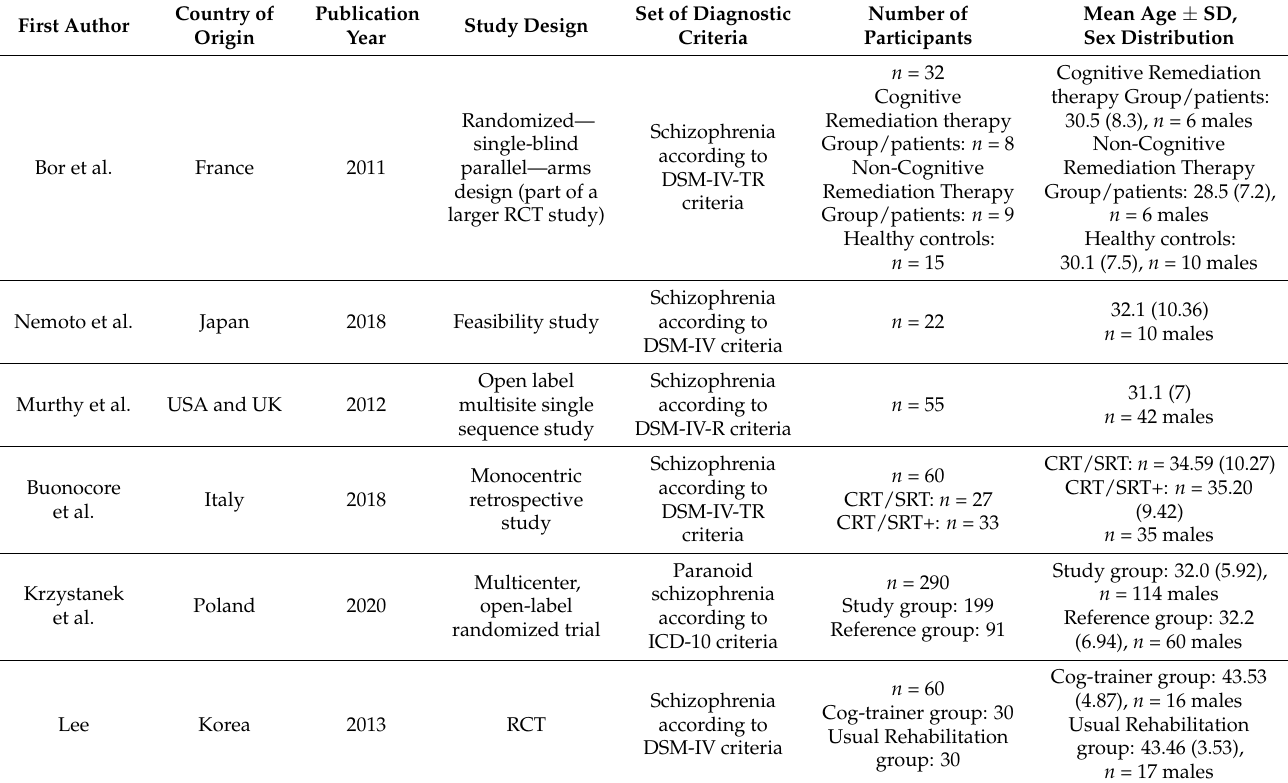
Table 1. Summary table of studies included in the present literature review—data